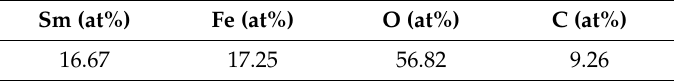
Table 2. Atomic concentrations (%) of Sm, Fe, O and C in the SmFeO 3 sample. Sm